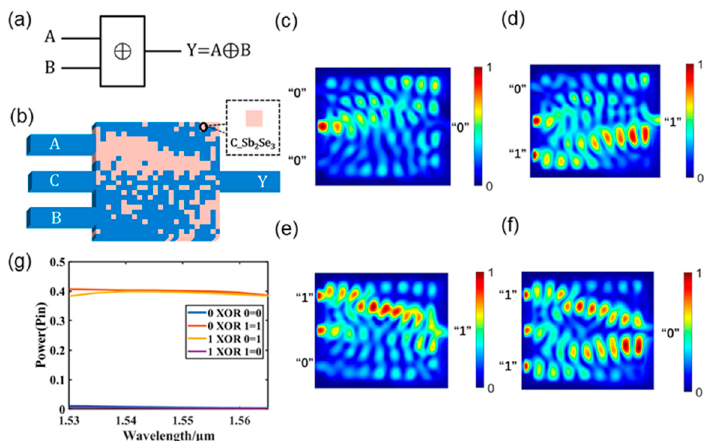
Figure 6. Photonic XOR logic gate. ( a ) Graphical symbols of the XOR logic gate; ( b ) designed XOR logic gate; ( c – f ) light field intensity distributions of all operations of the XOR logic gate; ( g ) output optical power diagram of the XOR logic gate in the C-band. Table 7. Photonic XOR logic gate power and binary output truth table data.